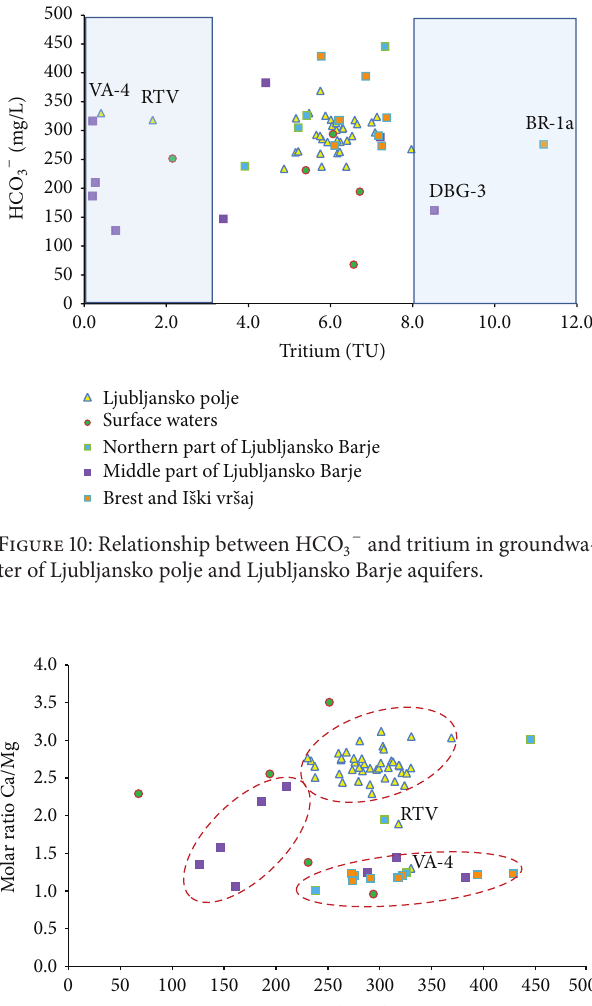
Groundwater of Ljubljansko polje aquifer with higher calcium content is recharged from infiltration of local pre- cipitations and drainage of Sava River water having recharge area mainly in Julian Alps and Karavanke mountains where limestone rocks dominate. Sava River water is depleted with 𝛿 18 O due to its recharge area mainly from higher altitude areas. Pronounced depletion of 𝛿 18 O was also detected at sampling locations in which the influence of recharged water from Sava River is important, while more positive values of 𝛿 18 O were recorded at sampling locations where local infiltration of precipitation dominates, further away from the Sava